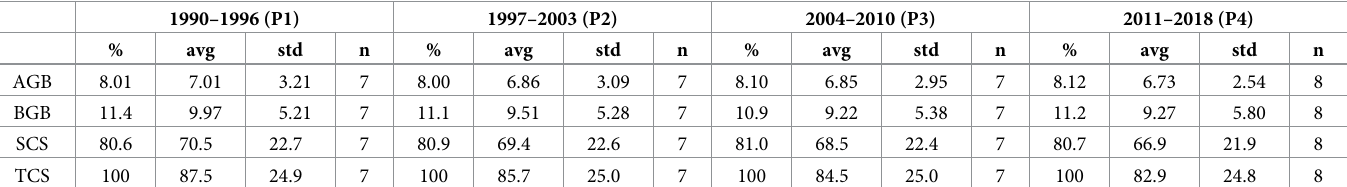
Table 7. Averages and standard deviations of annual values for aboveground biomass (AGB), belowground biomass (BGB), and soil carbon stocks (SCS 100 ) in Mg- C ha − 1 , and their relative percent contributions to total carbon stocks (TCS) for the periods 1990–1996 ( n = 7 ), 1997–2003 ( n = 7 ), 2004–2010 ( n = 7 ), and 2011– 2018 ( n = 8 ) in Western Bahia.